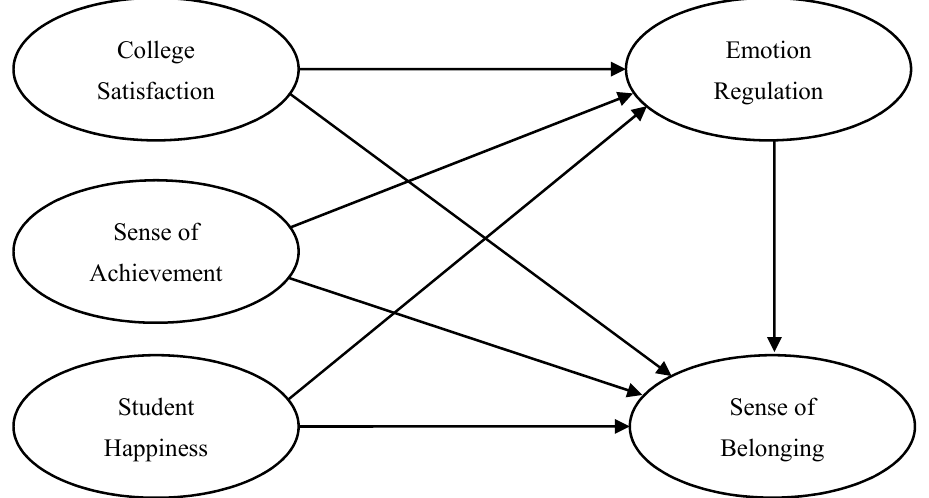
Figure 1. Conceptual model of relationships among college satisfaction, sense of achievement, student happiness, emotion regulation, and sense of belonging.